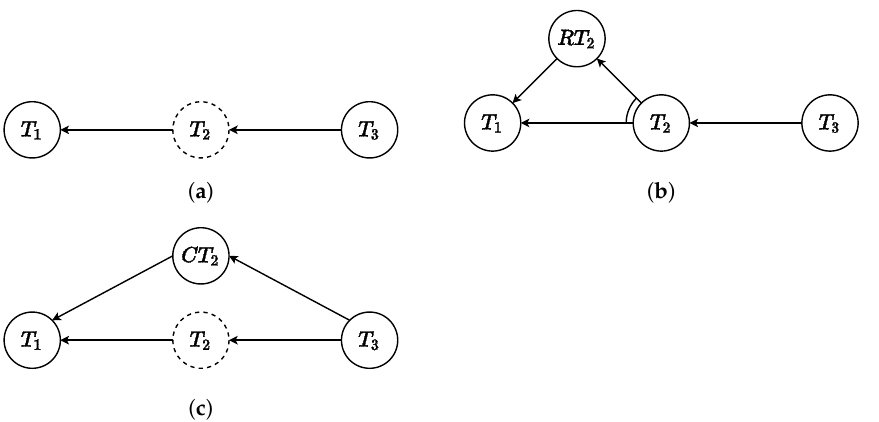
Figure 3. Representation of the errors and the adaptation of the AND/OR graph. The dashed line in ( a ) Means that T 2 failed. ( b ) Shows the restoring path, while ( c ) shows the corrective